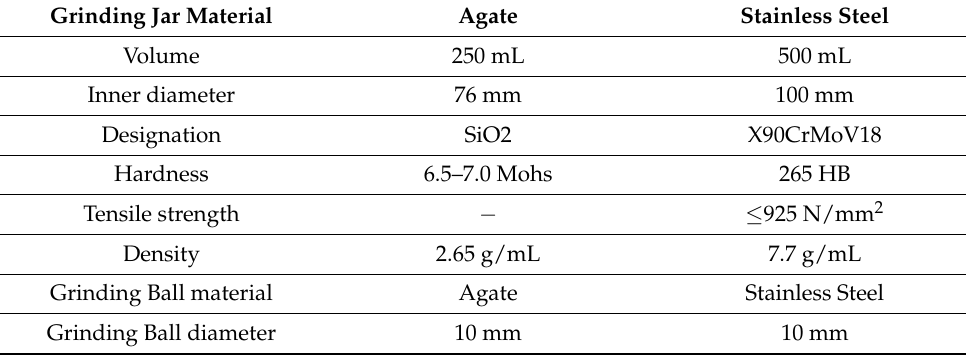
Table 1. Properties of the grinding jars and balls.